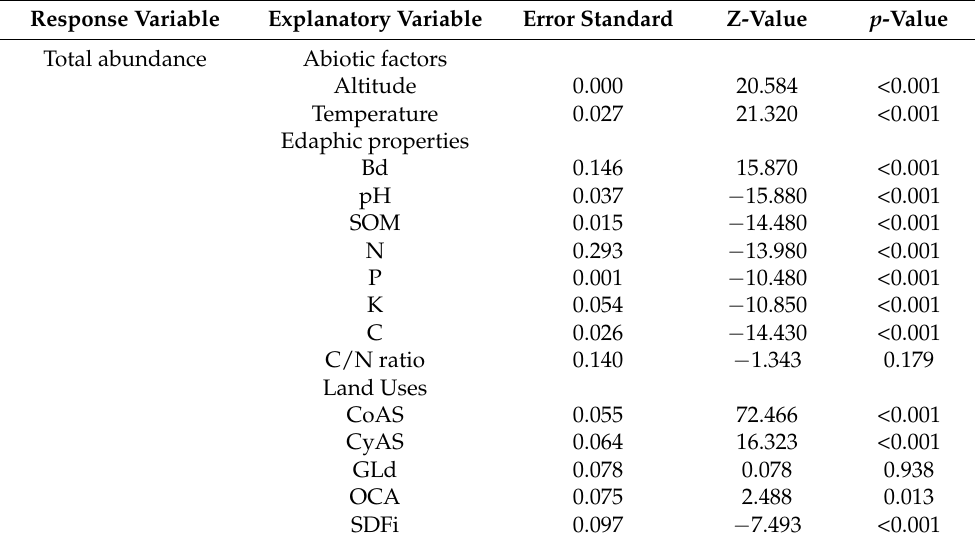
Table 6. Effects of abiotic, edaphic properties, and type factors of L-UCH on the total abundance of Scarabaeinae